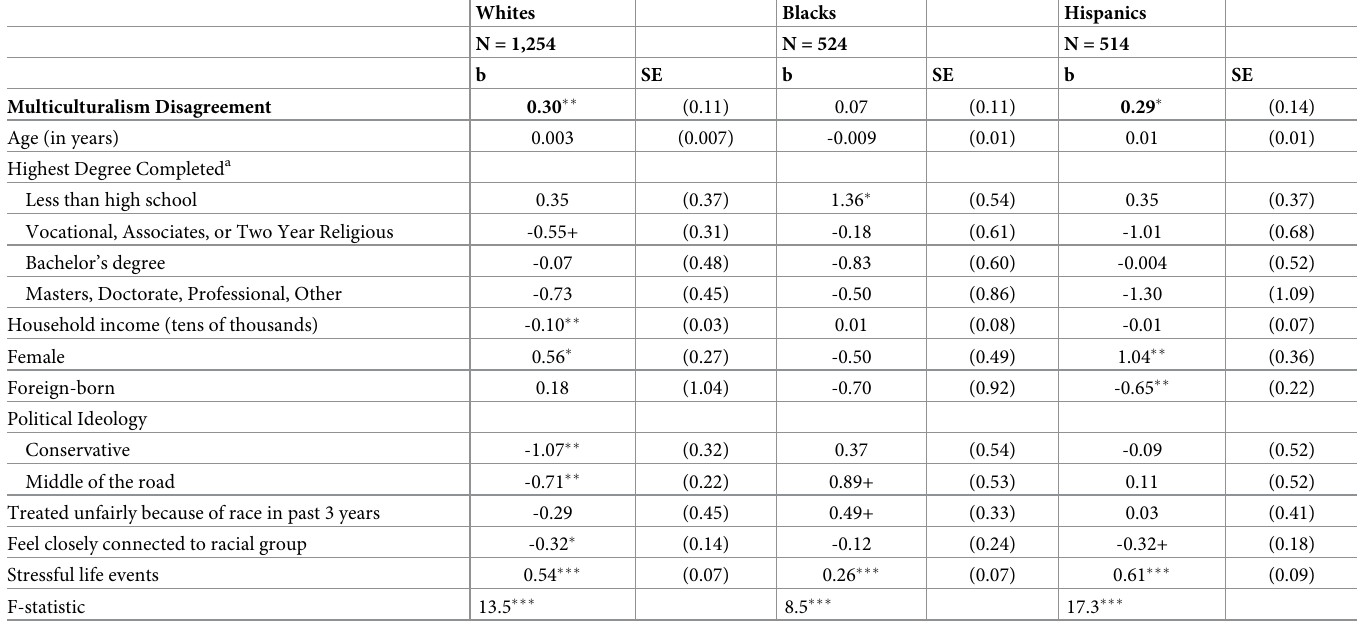
Table 2. Logit models estimating likelihood of psychological distress, by multiculturalism and